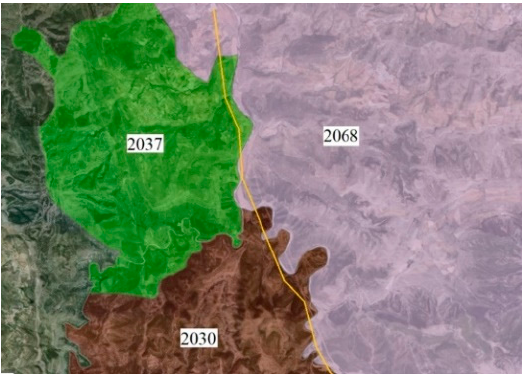
Figure 12. Proposed route of Project number 8, as it passes through the municipality 2037.